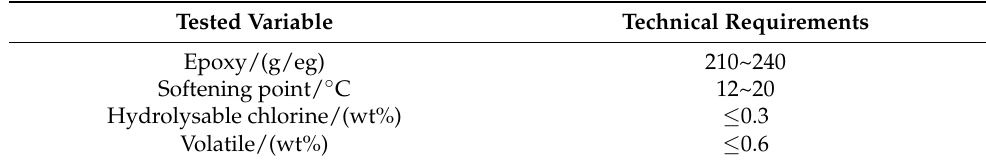
Table 3. Technical indicators of E-44 epoxy resin. Tested